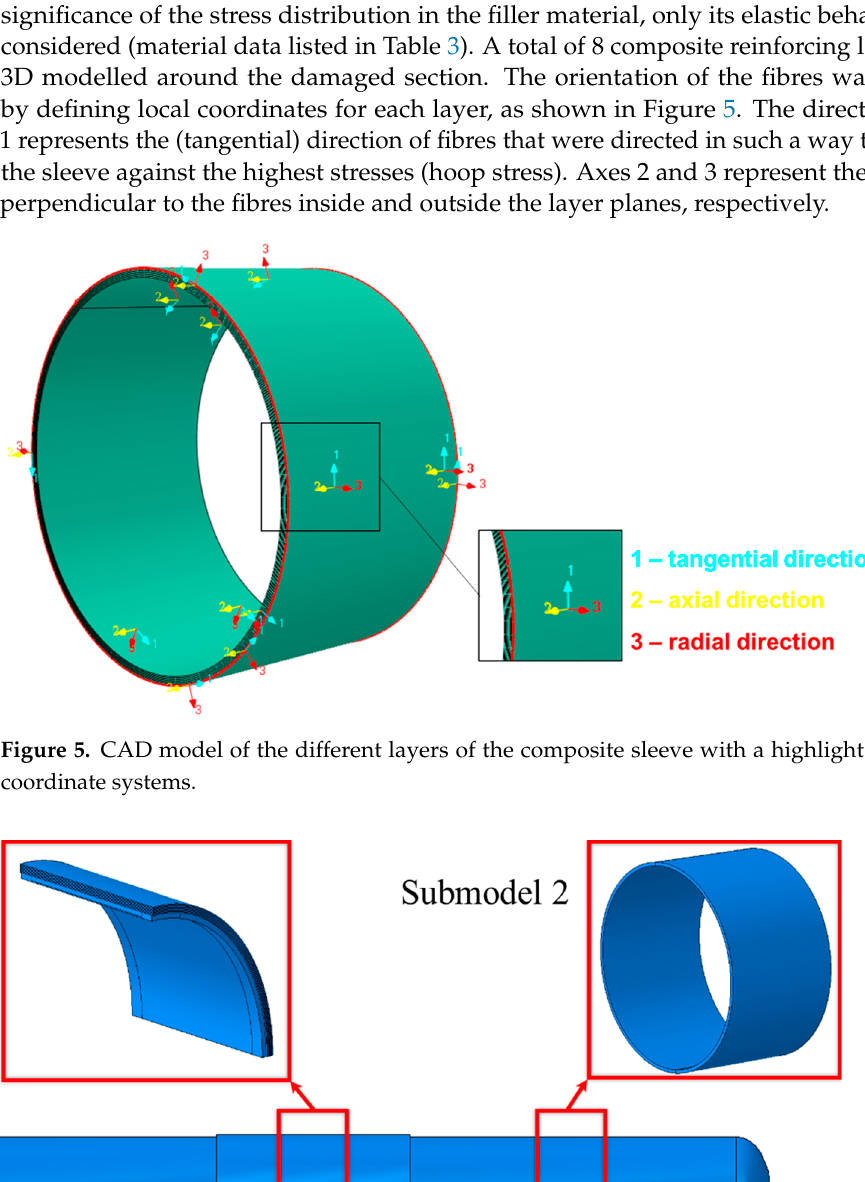
Table 3. Main mechanical properties of the adhesive filler.